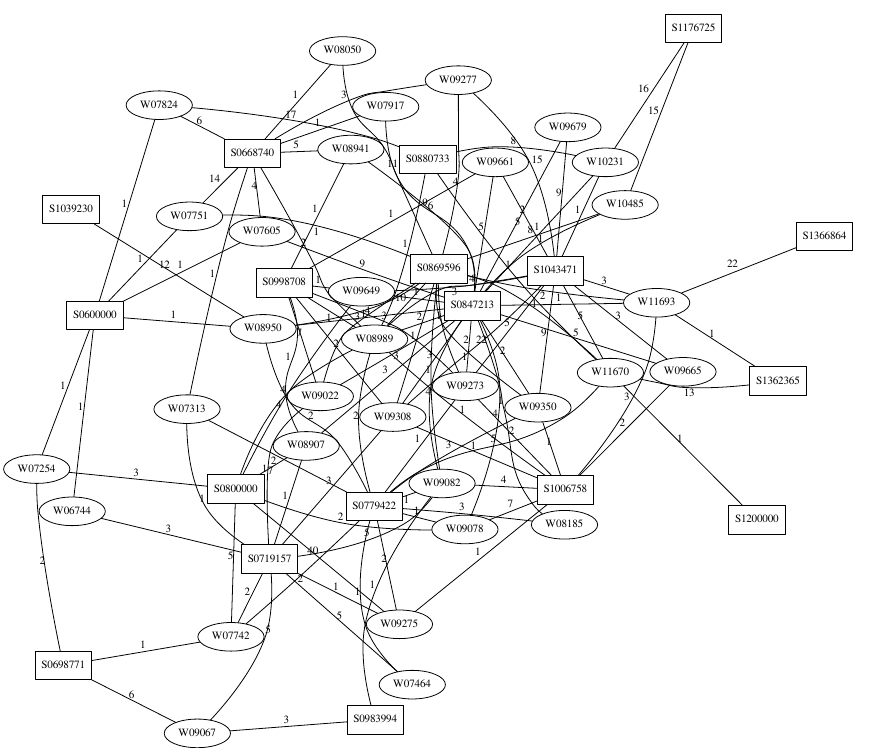
Figure 1 . A tiny part of the \watershed map" of critical points of the stationarity condition. Minima of the stationarity condition (at value zero) are (true and false) vacua of the potential, and labeled using the naming scheme introduced in [125]. Saddles are also labeled by cosmological con- stant, e.g. the saddle at (cid:0) V=g 2 (cid:25) (cid:0) 7 : 605 corresponds to W 07605. Edge labels indicate how many gradient-parallel (in naive geometry) paths along a principal axis run into a particular critical